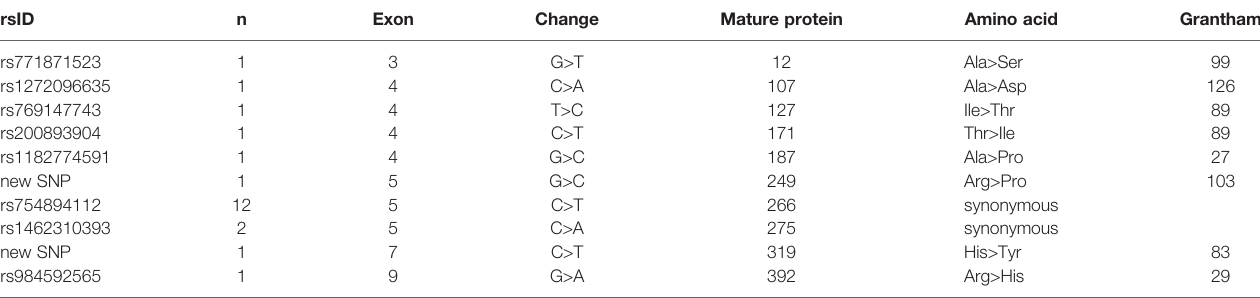
TABLE 2 | Ten con fi rmed novel single nucleotide variants in KIR3DL1S1 . rsID n Exon Change Mature protein Amino acid